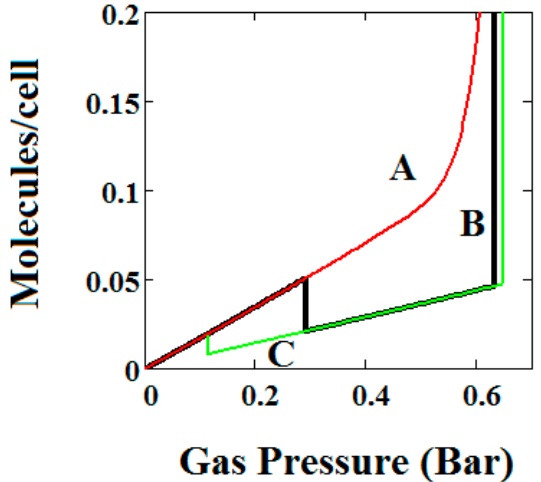
Figure 7. Plot of the behaviour of the methane adsorption in the theory MOF for three values of the parameter ∆ (A = 0.05, B = 0.025, C = 0.01 kJ/mole). Curves B and C show a NGA transformation. Low values of ∆ shift the NGA transformation to lower pressures while high values cause the transformation to disappear. The other parameters are T = 257 K, uglp = − 14.8 kJ/mole, ugnp = − 13.55 kJ/mole, J = − 1.08 kJ/mole, X = 5000 Å 3 , Y = 10,000 Å 3 , Nm = 40, scale = 0, nmaxlp = 21, nmaxnpb = 20.